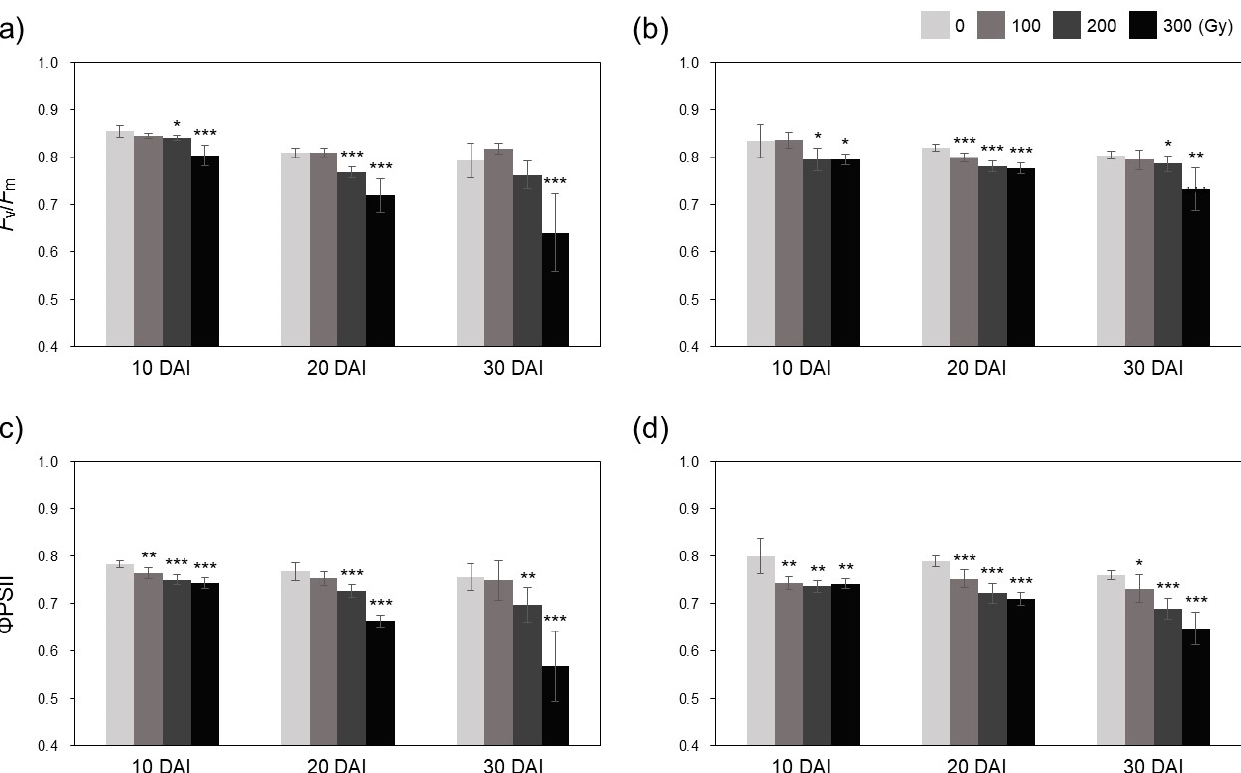
Figure 7. Photosynthetic efficiency of rice plants subjected to gamma irradiation. ( a – d ) Maximum quantum yield of PSII ( F v / F m ) ( a , b ) and quantum yield of PSII electron transport ( Φ PSII) ( c , d ) in rice plants subjected to acute ( a , c ) and chronic ( b , d ) gamma irradiation. DAI, days after irradiation. Data represent mean ± SD. Asterisks indicate significant differences between control (0 Gy) and other treatments (* p < 0.05, ** p < 0.01, *** p < 0.001).